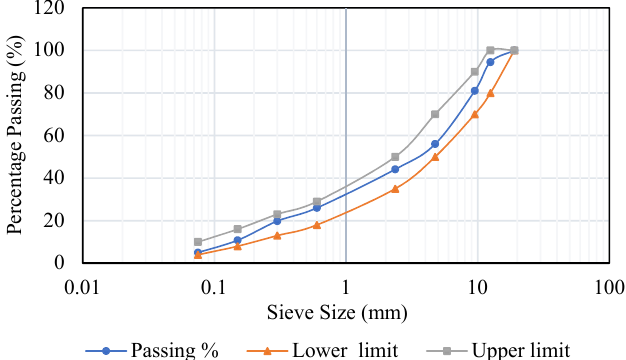
Figure 2. Design grading curves of the tested hot asphalt mixes, ASTM D3515-01 [69].